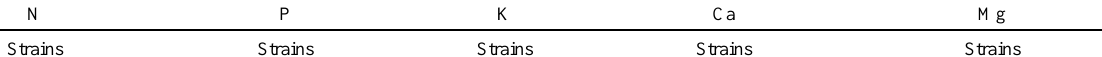
Table 6. Influence of addition of CaCO3 on content of micro and macronutrients in the caps of the fruiting bodies